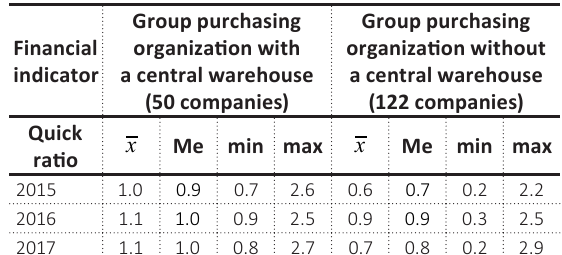
Table 4. Average results of quick